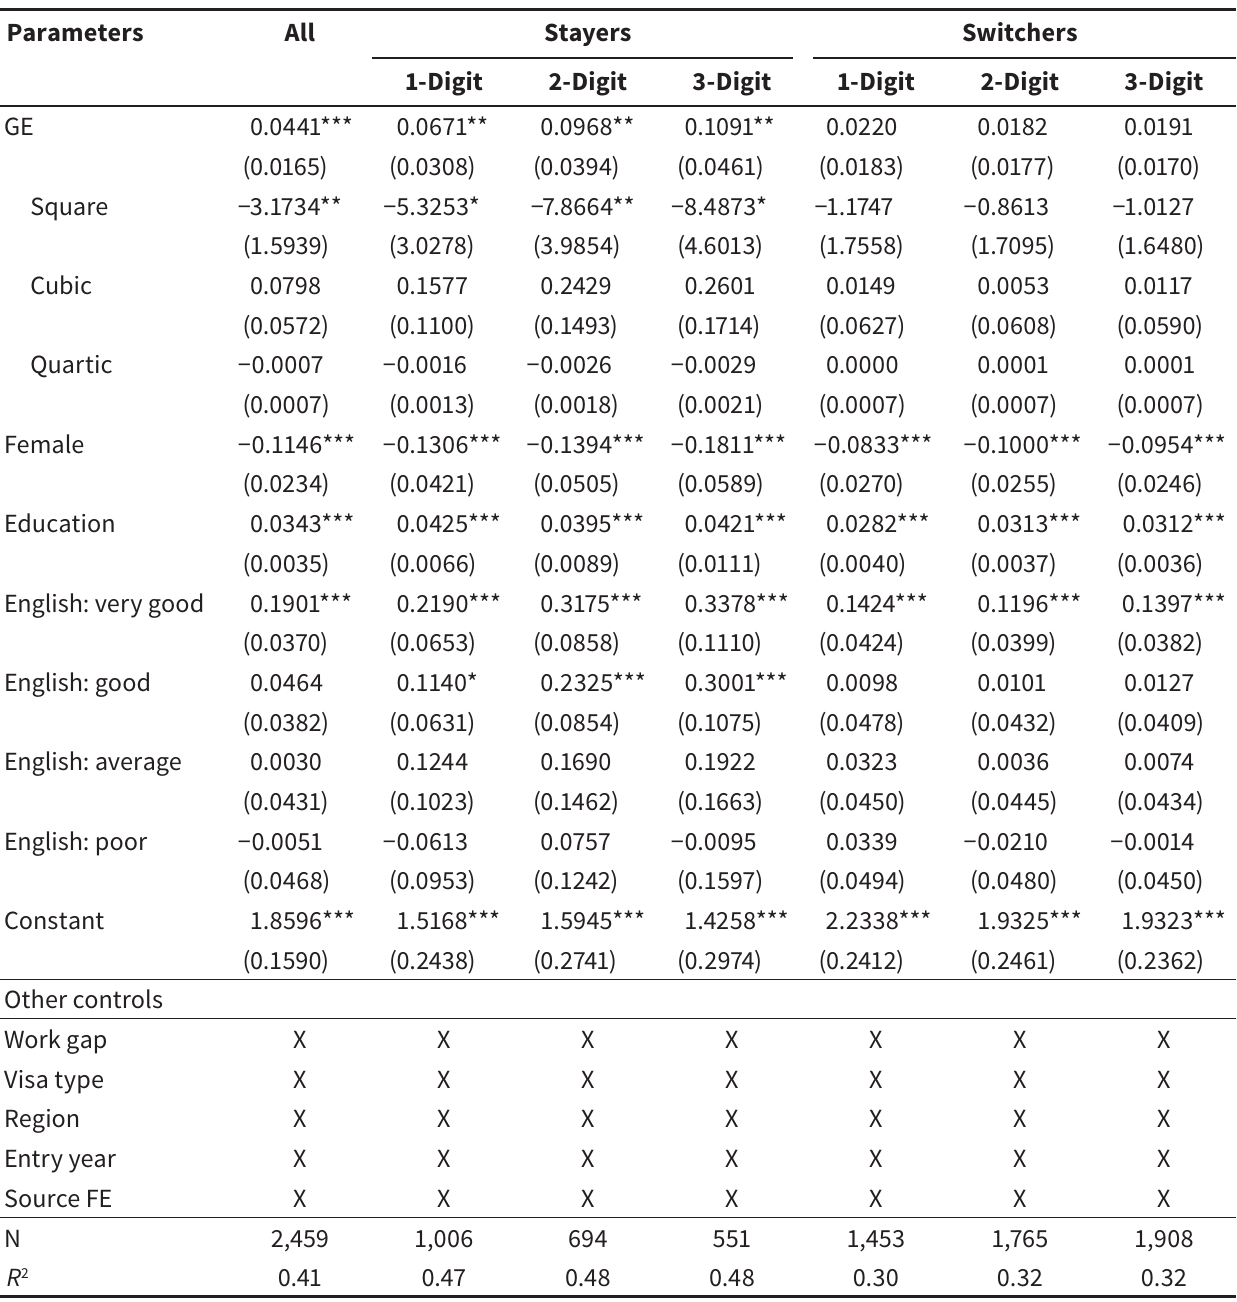
OLS: returns to source country general experience (quartic)